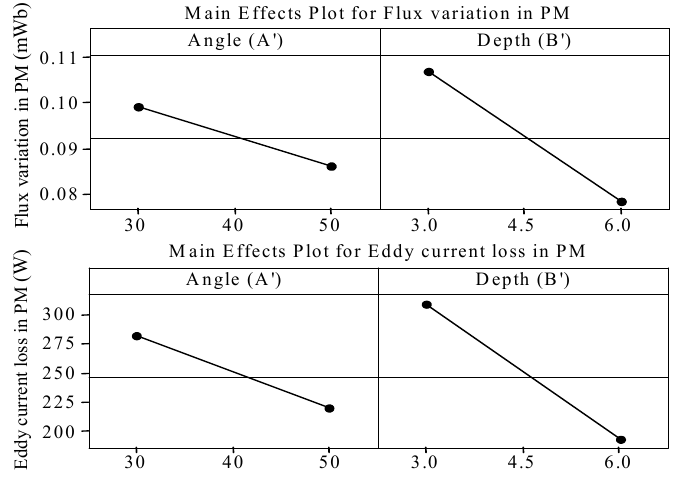
Figure 4. Main effect plot for the eddy current loss and square of the flux variation in the PM.